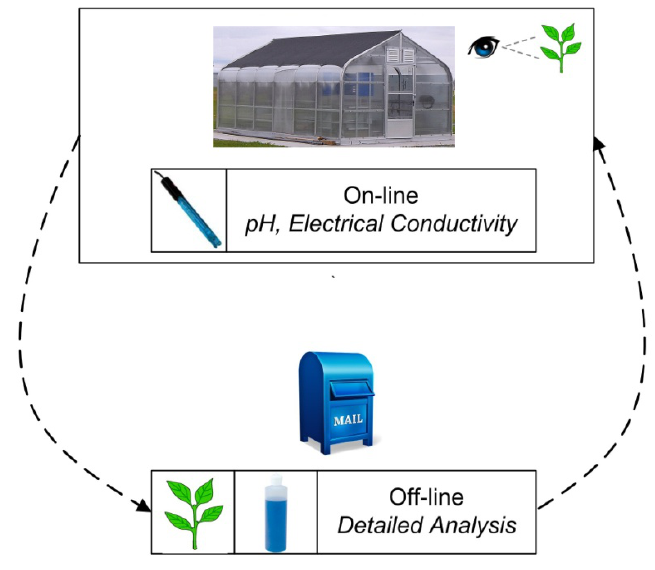
Figure 2. Conventional greenhouse nutrient solution monitoring. On-line monitoring of pH and EC is typically conducted and supplemented with grower observations of plant visual symptoms. Off-line analysis of plant tissue or samples of the hydroponic nutrient solution is also conducted at various intervals by sending samples off-site to accredited laboratories. Some or all of this information is utilized to make nutrient solution adjustment decisions well after the initial sampling